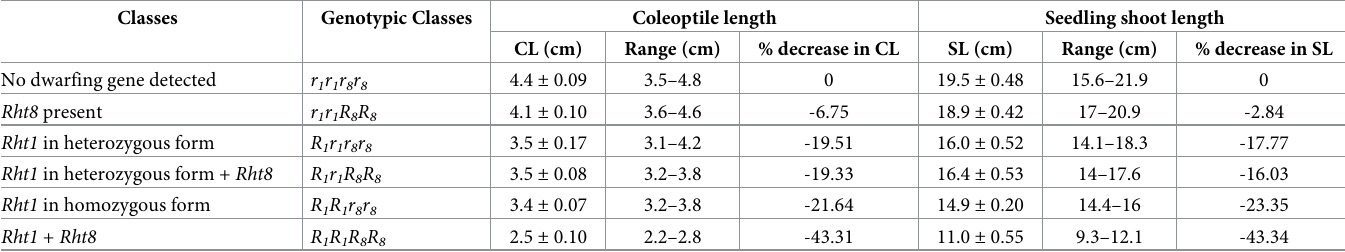
Table 1. Effect of Rht1 and Rht8 on seedling traits (CL and SL).